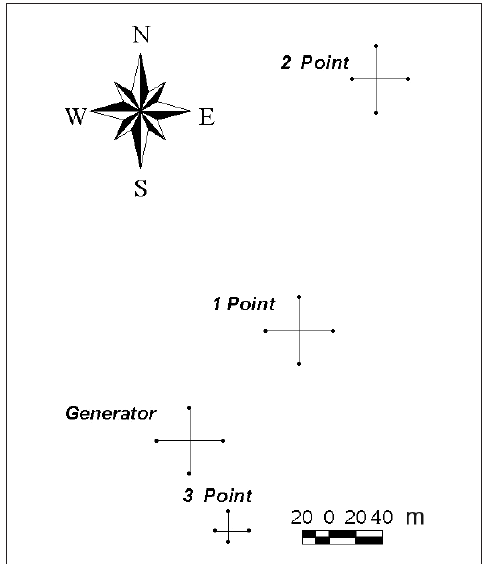
Fig. 2. The disposition of measuring and generat- ing lines. The Arabic numbers designate the points of